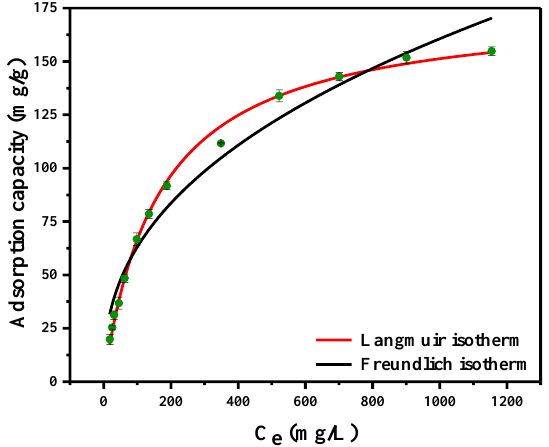
Figure 5. The non-linearly fitted curves of Langmuir and Freundlich model. Table 3. Non-linear adsorption parameters of PS-DMTD for Pd (II).